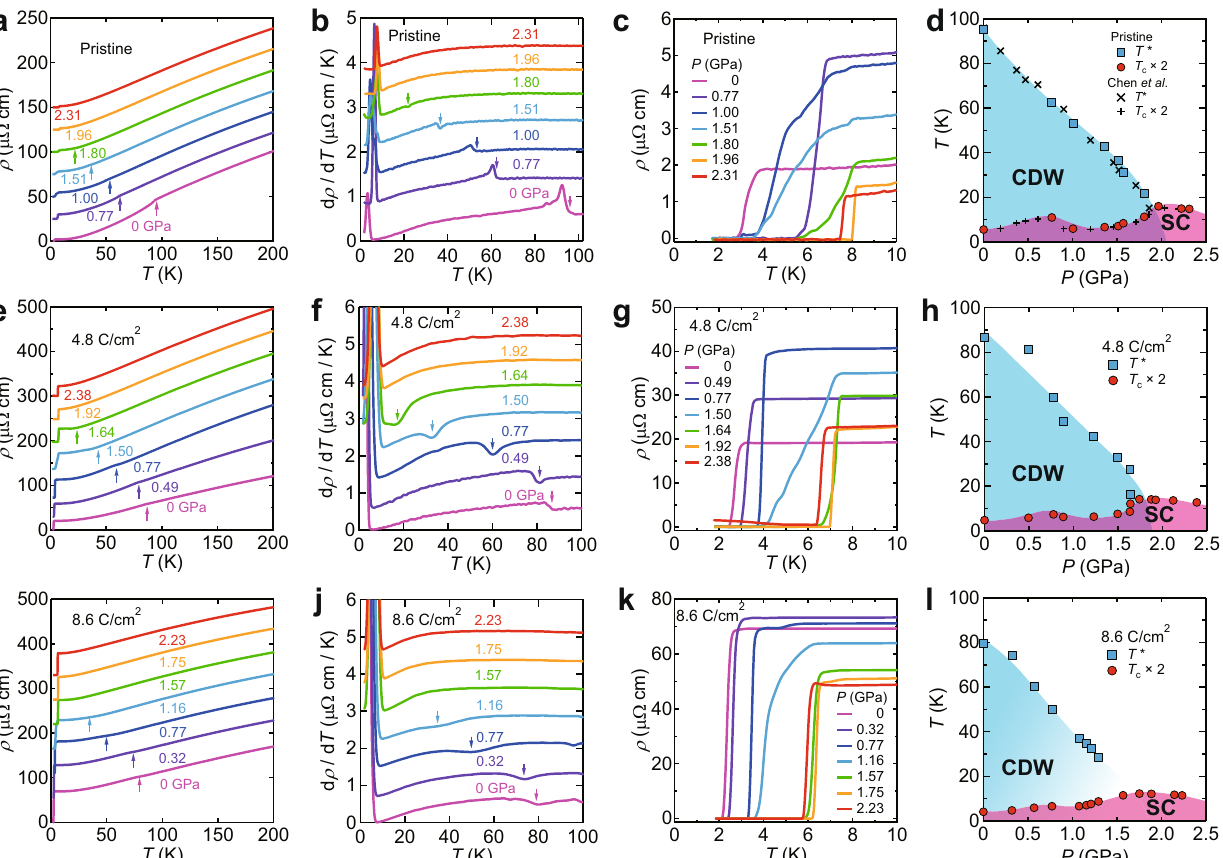
Fig. 4 | Pressure versus temperature phase diagrams ofpristine and irradiated CsV 3 Sb 5 .a , e , i ρ ( T )curvesbelow200Katseveralpressuresforthepristine( a ),4.8 ( e ), and 8.6 ( i ) C/cm 2 irradiated samples. Arrows indicate the CDW transitions determined from the d ρ / dT curves in b , f , j . b , f , j Temperature dependence of d ρ / dT below100K for the pristine ( b ), 4.8 ( f ),and 8.6 ( j ) C/cm 2 irradiated samples. Arrowsindicatethe CDWtransitions. c , g , k Low-temperature ρ ( T )curvesbelow10 K at several pressures for the pristine ( c ), 4.8 ( g ), and 8.6 ( k ) C/cm 2 irradiated samples. Note that the resistivity at 2.38GPa does not reach zero at low tempera- tures in g . This may come from distortion such as microcracks to the sample and damage to the terminals caused by solidi fi cation of daphne 7373 above 2